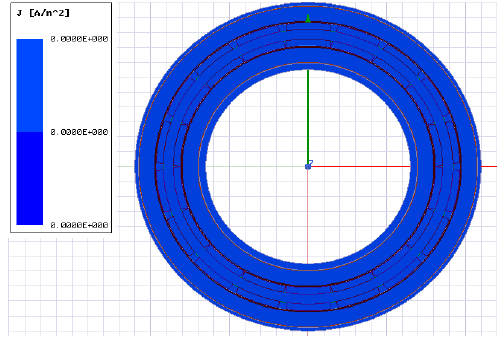
Figure 10. Cloud diagram of eddy current density.